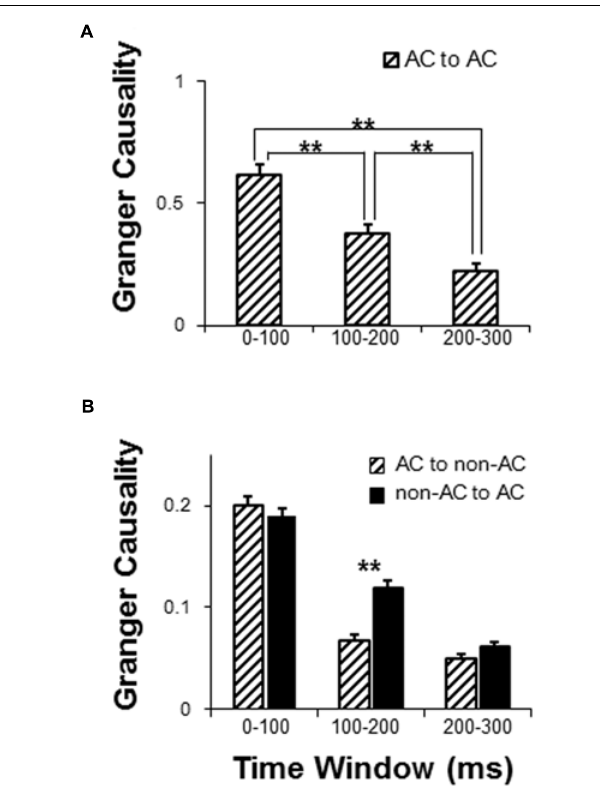
FIGURE 5 | Comparison of dynamic networks with in the following three time windows: 0–100, 100–200, and 200–300 ms. (A) Granger causality (GC) analyses of the auditory cortex local network. (B) GC analyses of functionally connected networks of the AC. AC , auditory cortex. ∗∗ p <